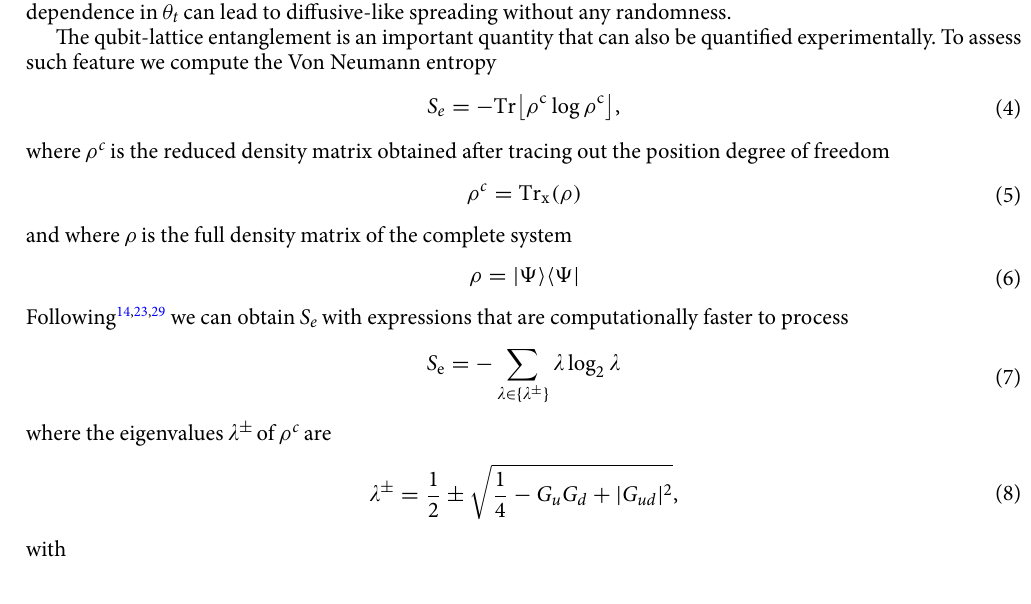
Figure 2. Diagram of the spreading regime versus the correlation C in the disorder for typical values r 01, 0.5, 0.9 . We compute α from m 2 ( t ) = { } t < 5 10 4 ×